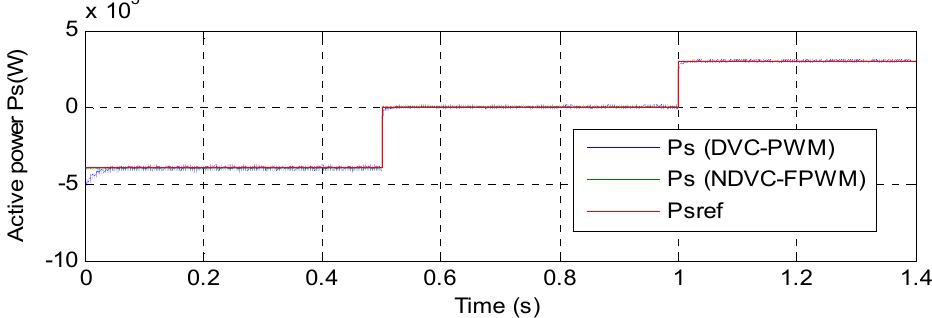
Figure 16. Active power.